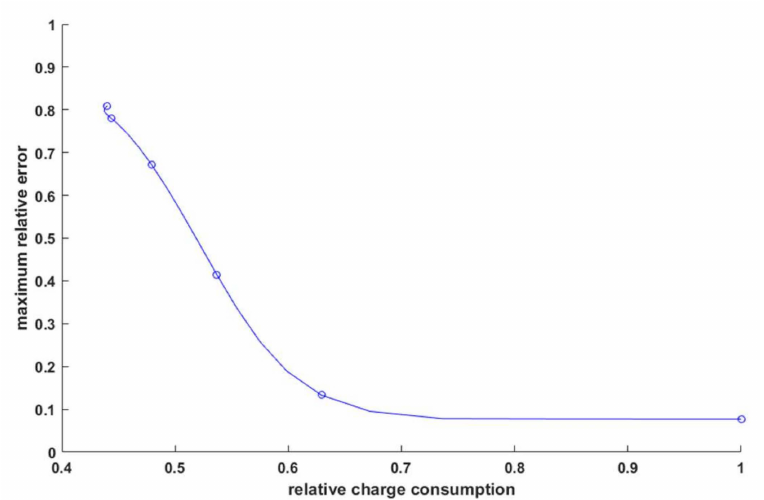
Figure 14. Dependence of the maximum relative error of distance estimation on the relative load